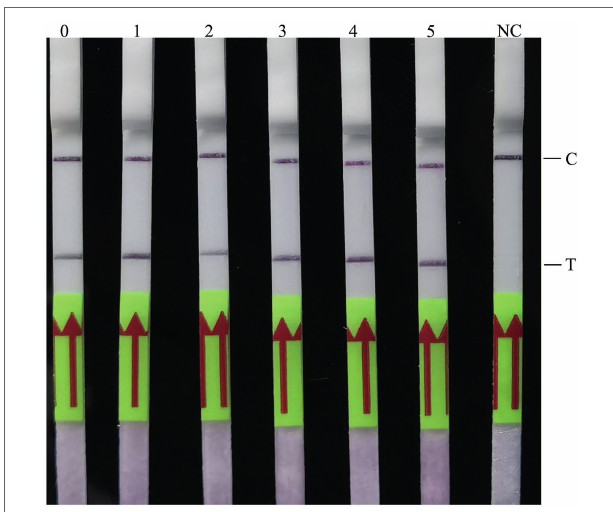
FIGURE 4 | Analytical sensitivity of the RAA-LF assay. Ten-fold serial dilutions of C. psittaci genomic DNA were evaluated by the RAA-LF assay, and deionized water was provided as negative control. A positive result was determined when both the low line of test (T) and the upper line of control (C) developed. Only C line occurrence indicated a negative result. Lines 0–5: 1 × 10 0 copy to 1 × 10 5 copies/ μ l. NC: negative